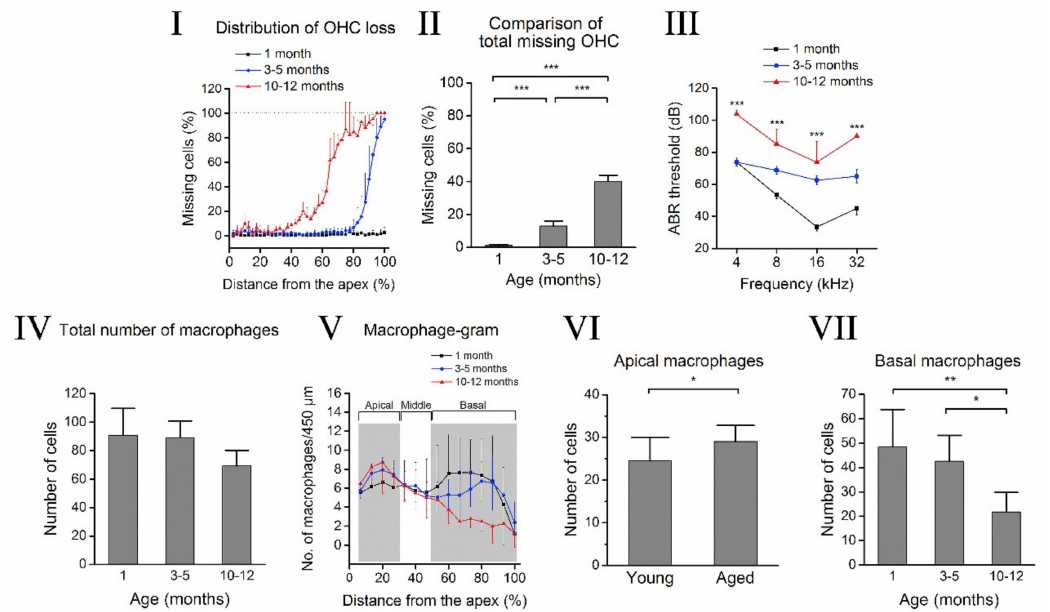
Figure 1. Age-related inflammation changes in the C57BL/6J mouse cochlea. ( I ) Cochleogram showing progressive OHC loss throughout the basilar membrane for different age groups of mice: young ( n = 13), intermediate-aged ( n = 20), and old ( n = 4) mice. Note that OHC loss starts from the cochlear basal end. ( II ) The number of missing OHCs is significantly higher in older age groups compared to the younger groups ( p < 0.0001). ( III ) ABR thresholds at 4 different frequencies show significantly higher thresholds for the older animal groups compared to the younger, baseline animals ( p < 0.001). ( IV ) Total number of macrophages in the sensory epithelium decreases between three age groups: 1 month ( n = 11), 3–5 months ( n = 16), and 10–12 months ( n = 4). ( V ) Macrophage-gram shows the number of macrophages in the basal region decreases with age at a higher rate compared to the apical and medial regions. ( VI ) The difference in microphage amount in the apex is significantly higher in aged animals (3–12 months) compared to the young animals (1 month) ( p < 0.05). ( VII ) A significant reduction in basal macrophages is observed between the age groups (*** p < 0.001, ** p = 0.002, * p = 0.014). From Frye et al. [82], with permission from the